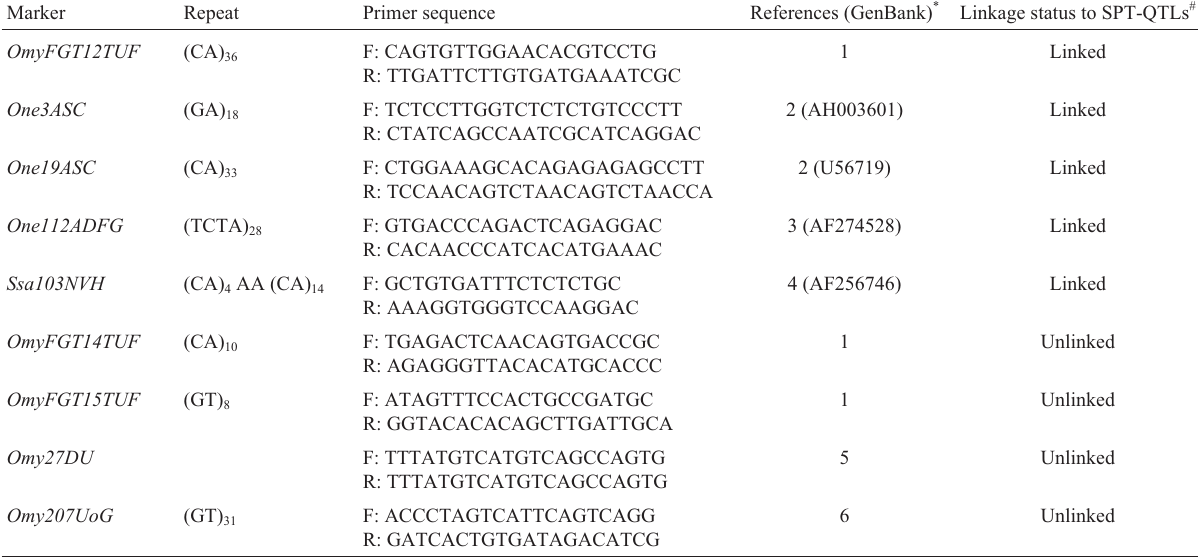
Table 1 - Description of the nine microsatellite markers analyzed. Marker